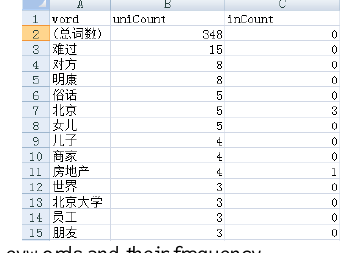
Figure 6. All points are placed by actual positions(left);All points are reallocated in an aligned grid(right).